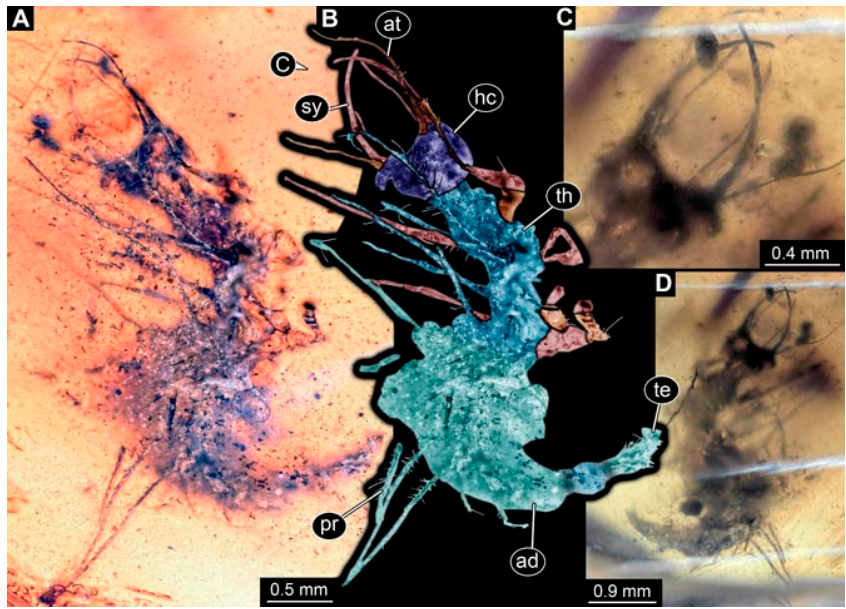
Figure 18. Specimen 4839 (PED 0375); Myanmar amber. ( A ) Ventral view. ( B ) Ventral view, colour- marked. ( C ) Close-up of head capsule in dorsal view. ( D ) Dorsal view. Abbreviations: ad = abdomen; at = antenna; hc = head capsule; pr = protrusions; sy = stylet; te = trunk end; th = thorax.